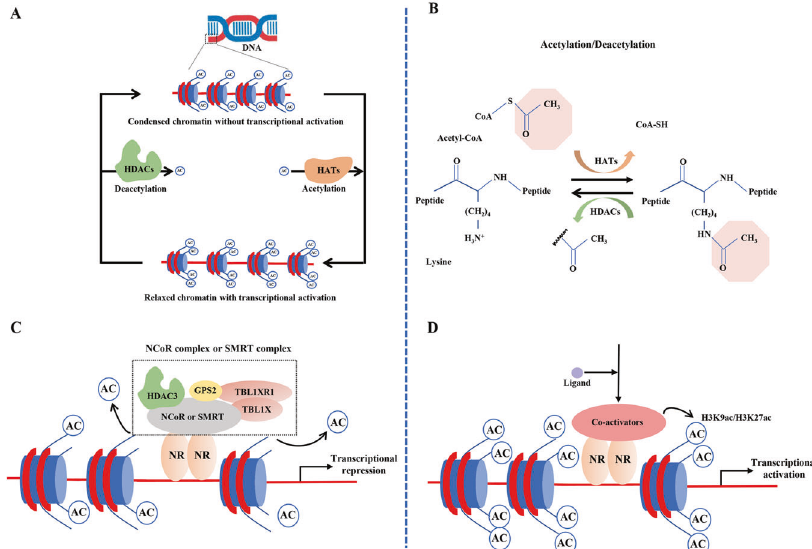
Fig. 1 Schematic representation of the histone acetylation and deacetylation by HATs and HDACs. A Condensation and relaxation of chromatin due to histone deacetylation and acetylation, respectively. Histone acetylation levels are determined by the interplay between HATs and HDACs. Activation of HDACs leads to a net decrease of histone acetylation, chromatin condensation, and transcriptional repression. Activation of HATs results in a net increase of histone acetylation, chromatin relaxation, and transcriptional activation. B The chemical formula of histone acetylation and deacetylation. C Nuclear receptor co-repressor complexes containing HDAC3, GPS2, TBLX, and TBL1XR bind to nuclear receptors without ligands to induce transcriptional repression via histone deacetylation. D Nuclear receptor-mediated ligand binding inhibits the co-repressor complex and recruits co-activators, facilitating histone acetylation and gene transcription.